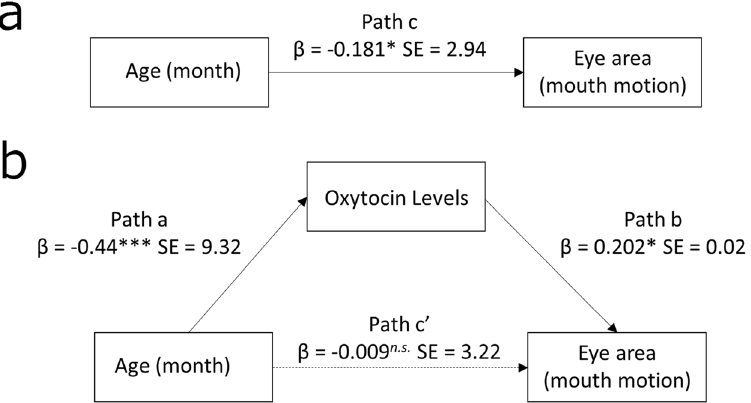
Figure 3. The role of oxytocin in mediating the influence of infant age on gaze fixation on the eye area (Human face [without mouth motion]). * p < 0.05; *** p < 0.001.